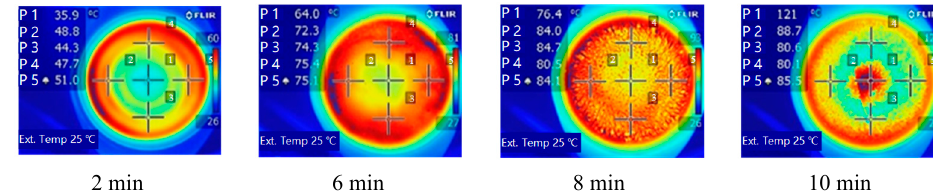
Figure 4. Thermal images of the berry puree at the microwave intensity of 8 W/g.